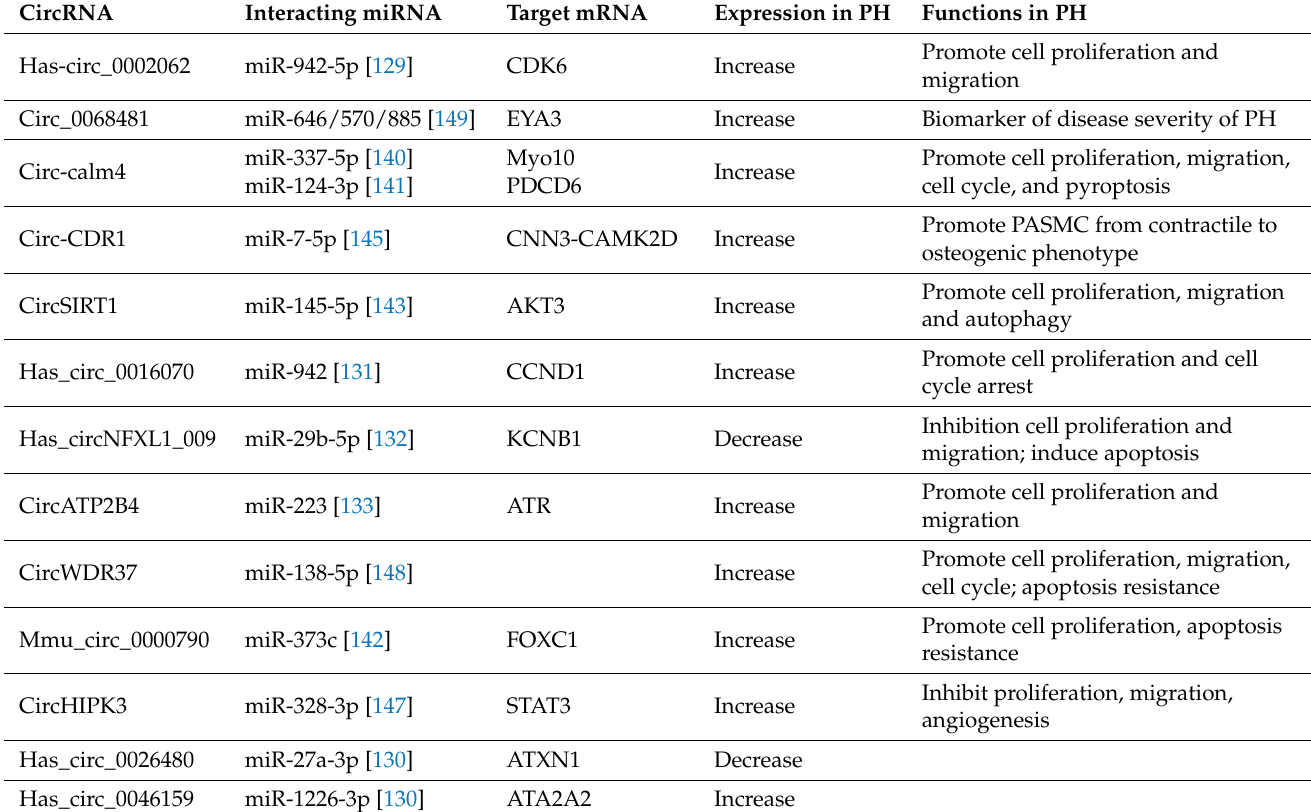
Table 1. Selected circRNAs act as miRNA sponges and positively regulate their genes in